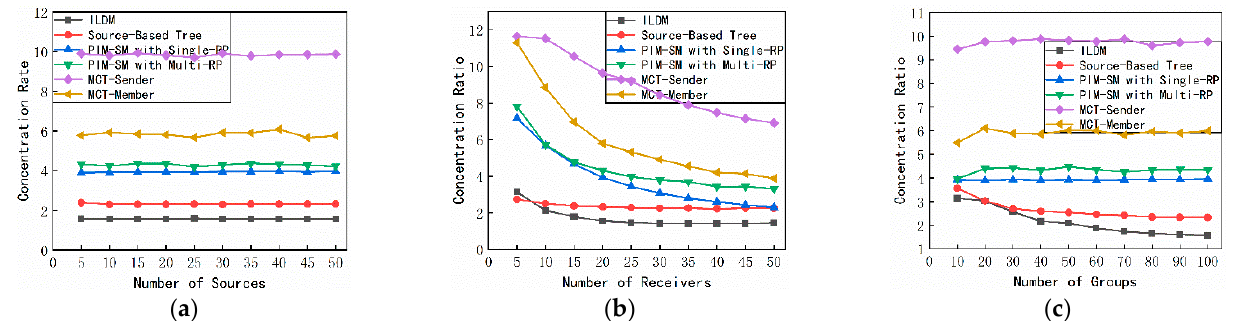
Figure 9. The comparison of link loads’ standard deviation. ( a ) The variation trends of link loads’ standard deviation with a different number of sources; ( b ) the variation trends of link loads’ standard deviation with a different number of receiv- ers; ( c ) The variation trends of link loads’ standard deviation with a different number of groups.